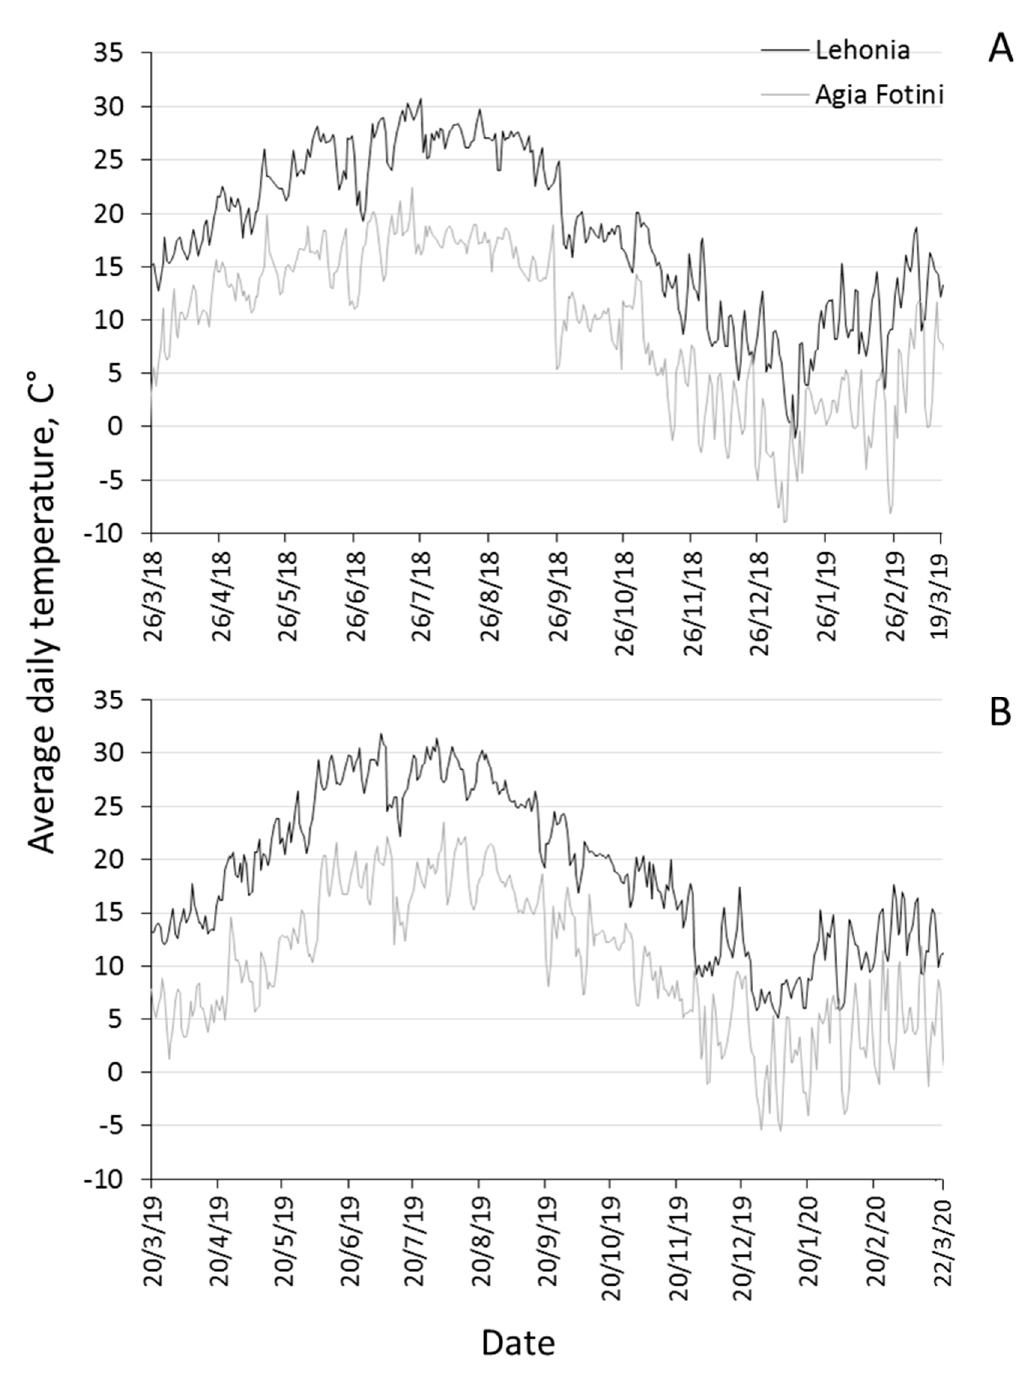
Figure 1. Seasonal patterns of daily temperature in Lehonia and Agia Fotini from 26 March 2018 to 19